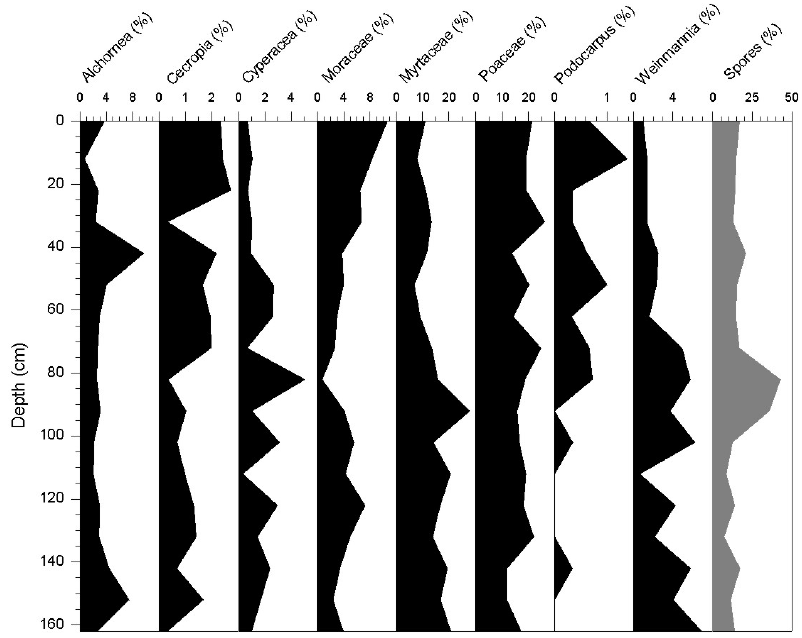
Fig. 4 – Percentage of Alchornea , Cecropia , Cyperaceae, Moraceae, Myrtaceae, Poaceae, Podocarpus , Weinmannia and spores from Lagoa